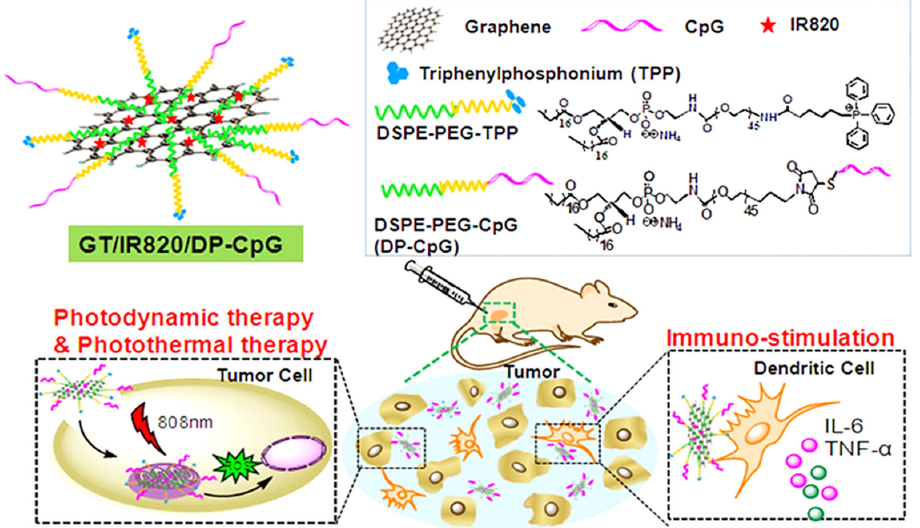
Figure 7. The “triple-punch” anticancer strategy mediated by NIR photosensitizer IR820/CpG oligonucleotides and mitochondria-targeted TPP-modified nanographene for photody- namic/photothermal/immunotherapy. Reproduced with permission from [112]. Copyright 2018. American Chemical